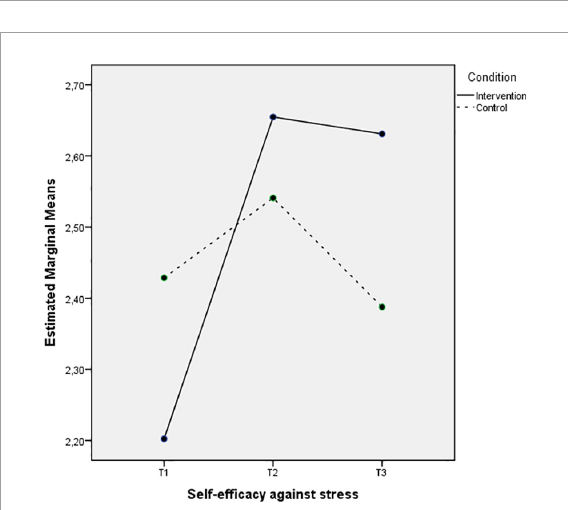
FIGURE6 Mean of self-efficacy against stress showing time effects for control and intervention groups.